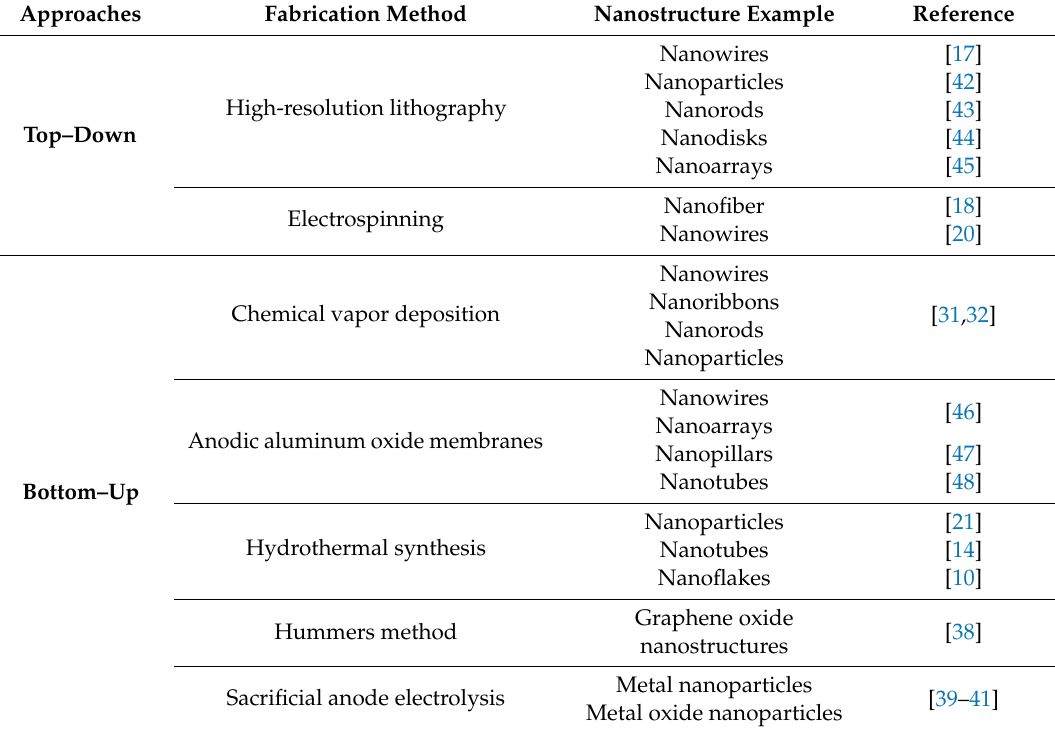
Table 1. Nanostructure synthesis